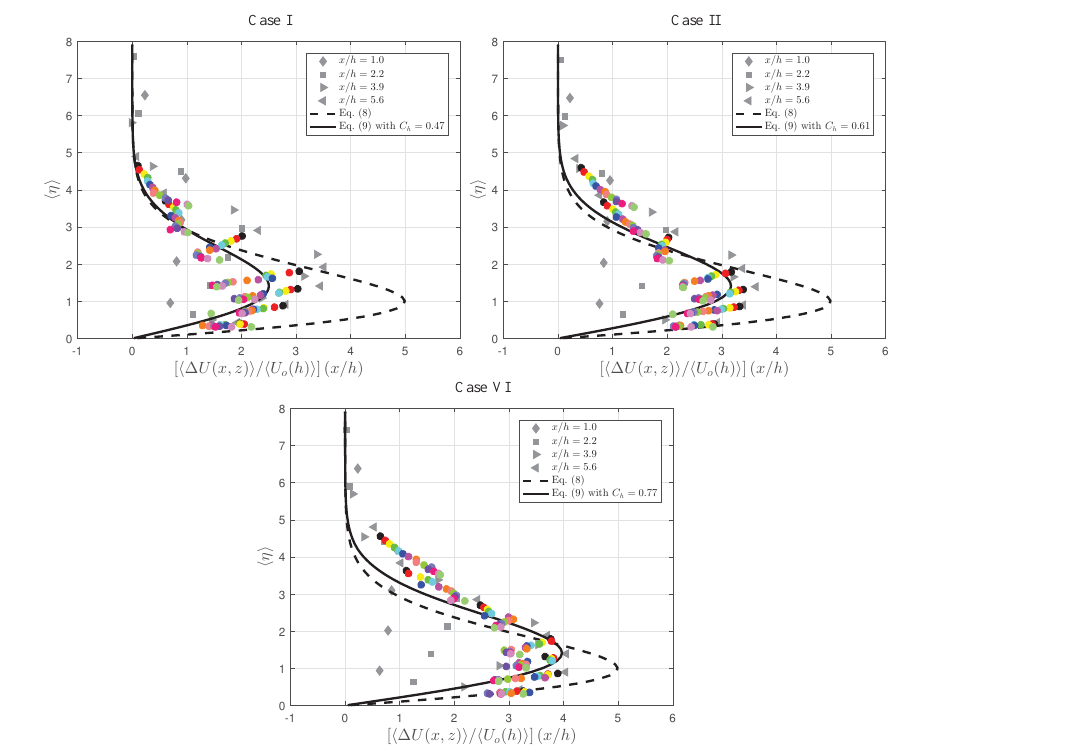
Figure 13. Self-preserving profiles for three cases and a number of downwind distances (details in the text). Results from Eqs. (8) and (9) are also